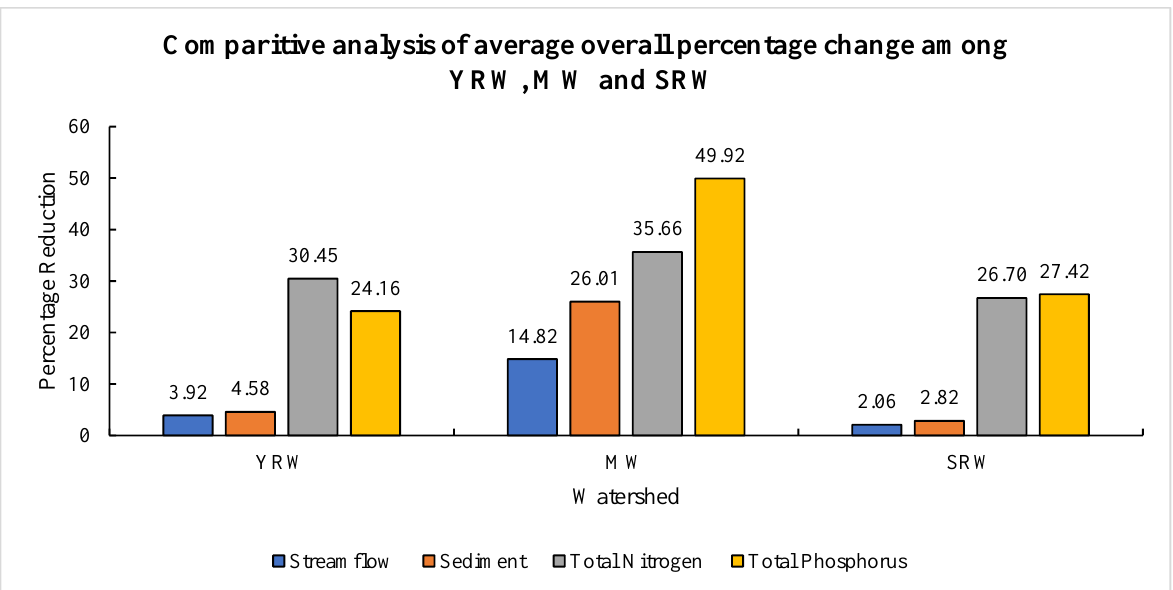
Figure 5. Overall average comparative assessment in percentage reductions for YRW, MS, SRW.